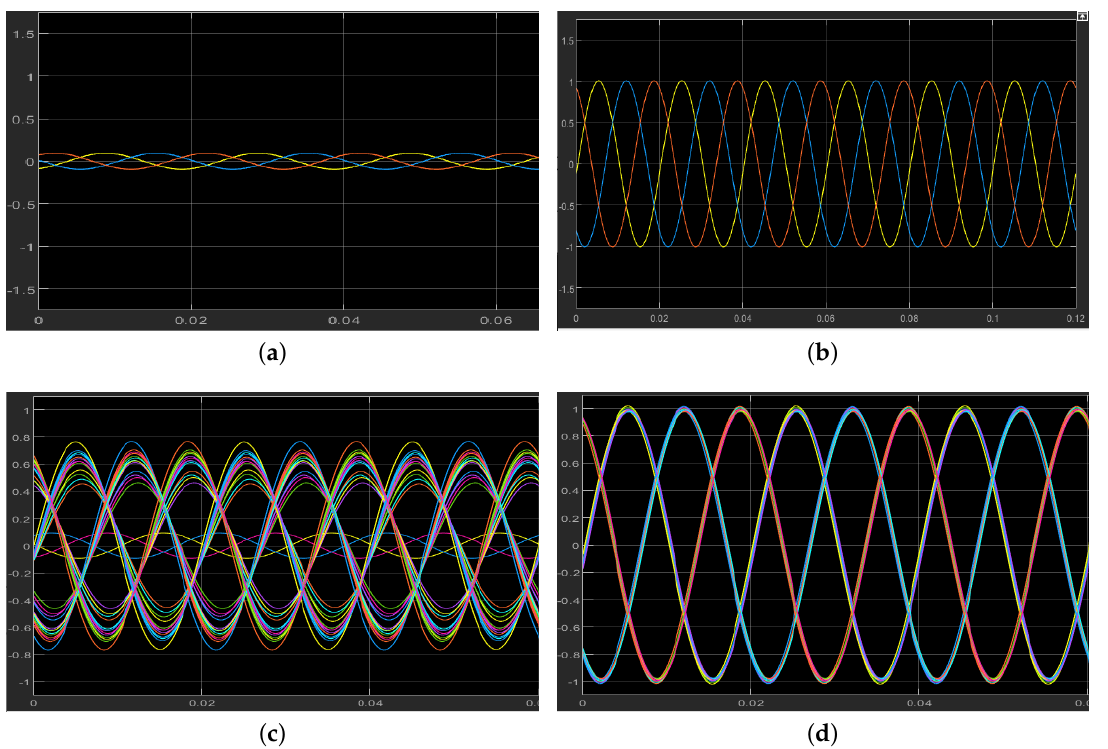
Figure 7. Stability and instability of 33-busses with and without multiagent system. ( a ) Unstable bus 20: Without MAS deployment in it. ( b ) Stable bus 20 after MAS deployment in it. ( c ) When one of the buses is unstable: Without-MAS deployment in the system. ( d ) 33-busses are stable after deployment of MAS in the